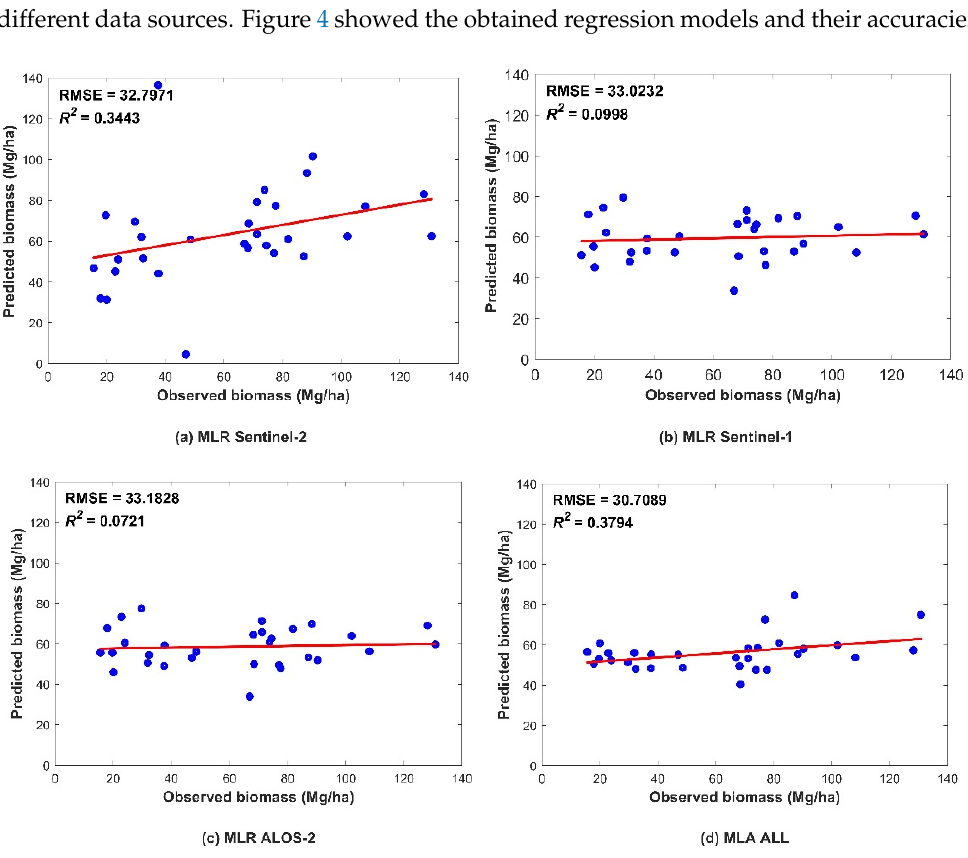
Figure 4. Scatter plots showing the accuracies of the MLR models obtained using the following remote-sensing data: ( a ) Sentinel-2, ( b ) Sentinel-1, ( c ) ALOS-2, and ( d ) all three data sources. The blue dots indicate a pair of corresponding predicted and observed values. The red line indicates the trend line.